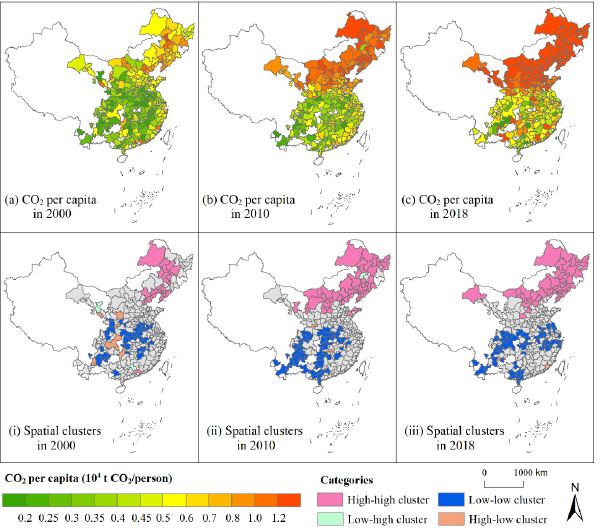
Figure 2. Spatial distribution and clusters of CO 2 per capita in the years 2001, 2010, and 2018. (( a – c ) represents the spatial distributions of CO 2 per capita in 2000, 2010 and 2018, respectively; ( i – iii ) denotes the spatial clusters of CO 2 per capita in 2000, 2010 and 2018, respectively)